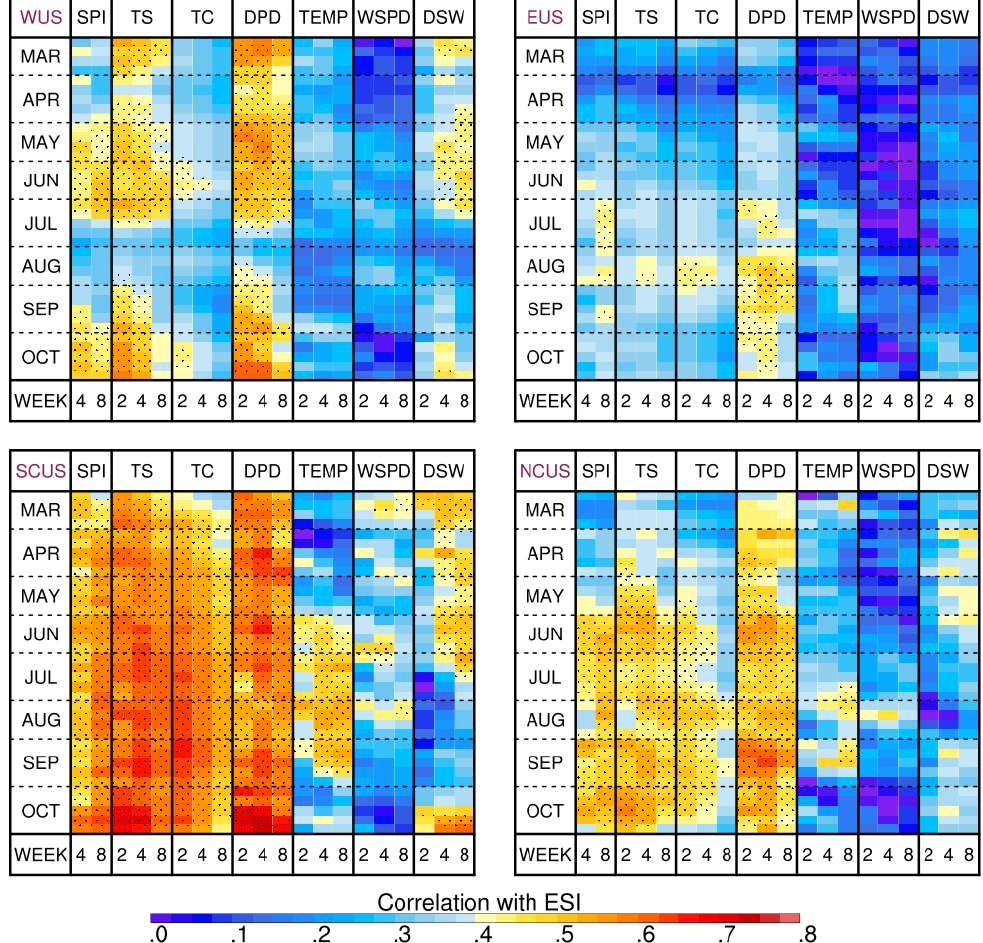
Figure 4. Weekly time series of correlations between the 2-week ESI and each forcing variable computed using all land grid points in the western (WUS), eastern (EUS), south-central (SCUS), and north-central (NCUS) US and data from 2001 to 2015. Correlations to the 4-, 8-, and 12-week SPI are shown in columns 1–3, with correlations to the 2-, 4-, and 8-week TS, TC, DPD, TEMP, WSPD, and DSW variables shown in columns 4–6, 7–9, 10–12, 13–15, 16–18, and 19–21, respectively. Note that the sign has been reversed for the DPD, TEMP, WSPD, and DSW correlations so that positive correlations indicative of enhanced drying are shown in yellow and red colors. The stippling denotes the weeks and variables for which at least half of the grid points in a given region had a statistically significant correlation at the p = 0 . 1